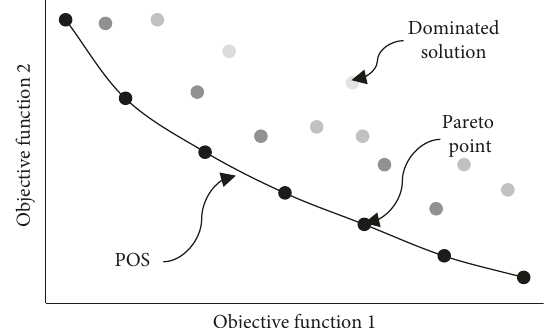
Figure 1: Pareto optimal